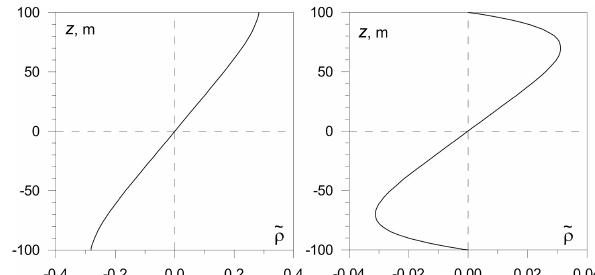
Figure 1. Modeled vertical profiles of density disturbances Re( d F/ d z) = Reρ = e ρ for case 1. Unstable (growing) solution for boundary conditions of type 1 (left) and type 2 (right) = 1 . 5, K = 10 − 5 m 2 s − 1 , ) = 0 . 5 (ks/K) 1 / 2 H 2 for χ = Re( − aH 2 0 0 H 0 = 100m, and s = 10 − 7 m − 1 s − 1